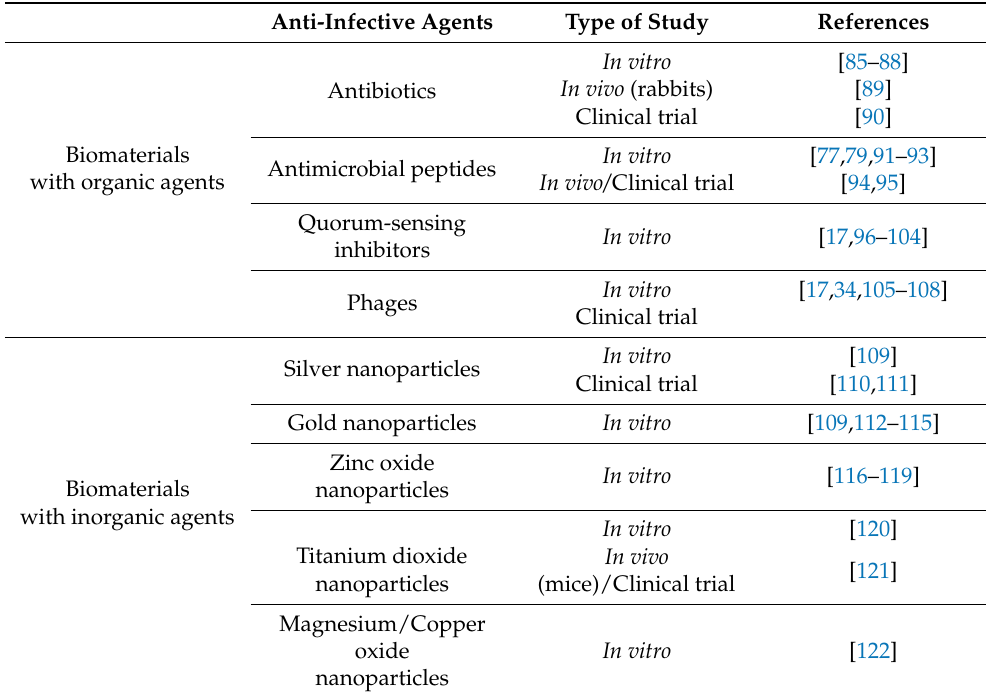
Table 2. Some examples of active biomaterials in fighting bone-related biomaterial